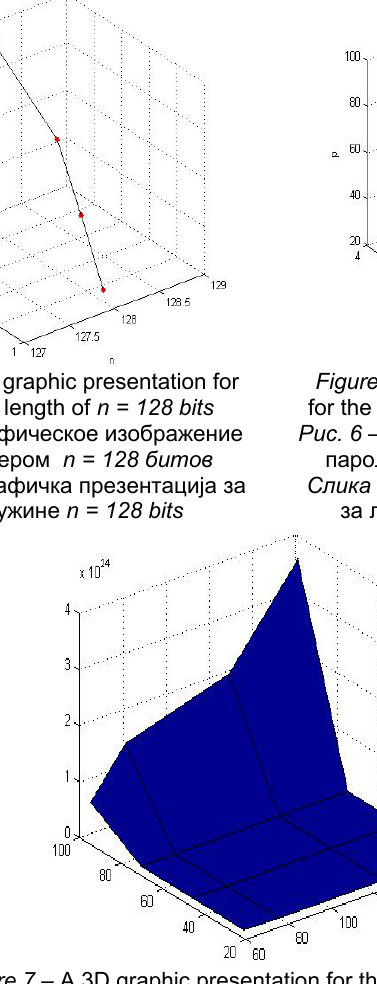
Figure 7 – A 3D graphic presentation for the password length of n = (64, 80, 128, 160) bits Рис . 7 – 3 Д графическое изображение пароля размером n = (64, 80, 128, 160)